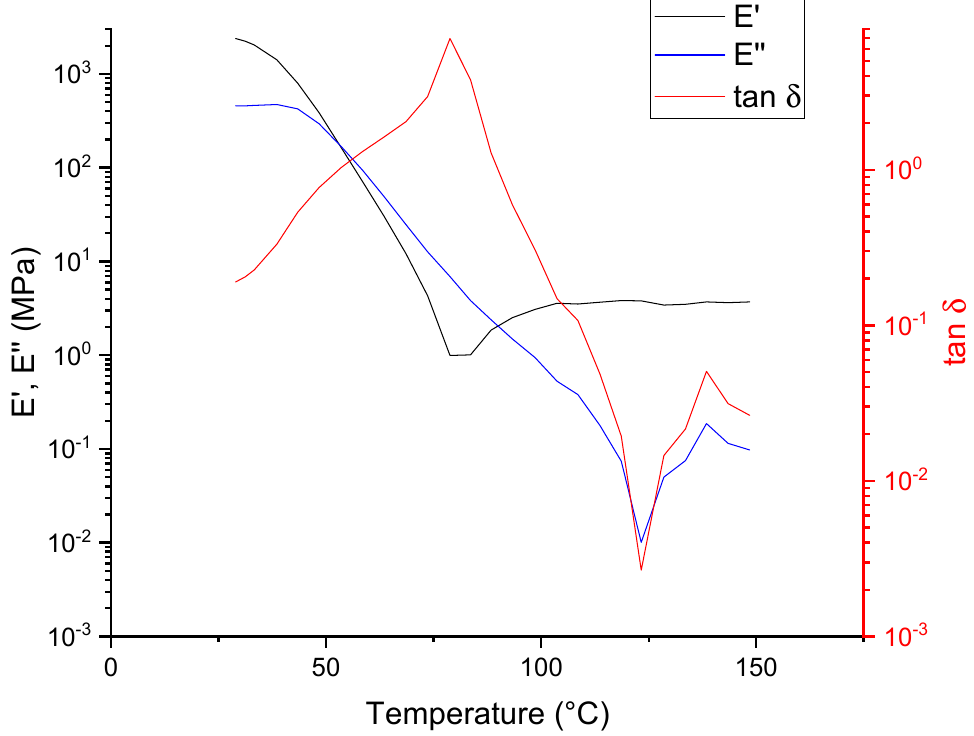
Figure A2. Results of the rheology and DMTA measurement of the urea-crosslinked copolymer network.